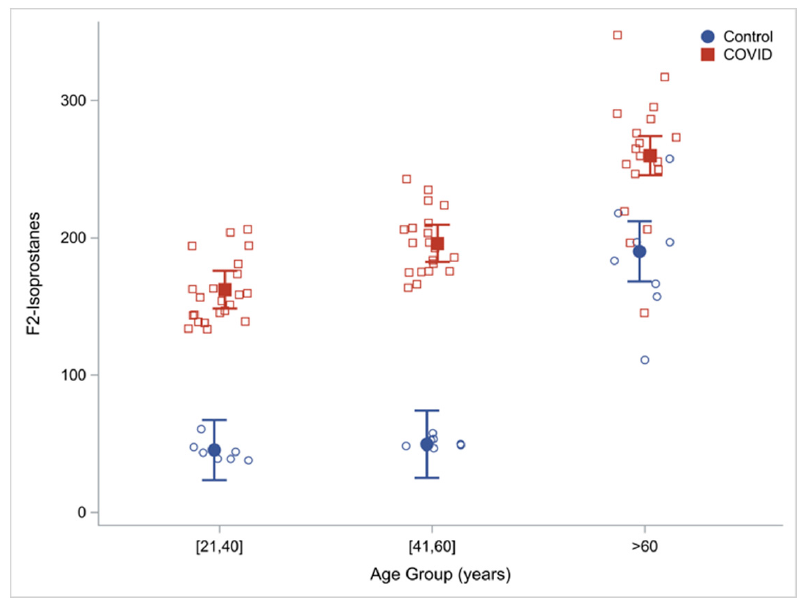
Figure 3. Damage due to oxidative stress: plasma F2-isoprostane concentrations by age and cohort (COVID-19 patients vs. uninfected controls) with regression estimated means (95% CI) adjusting for cohort, age, group and sex.